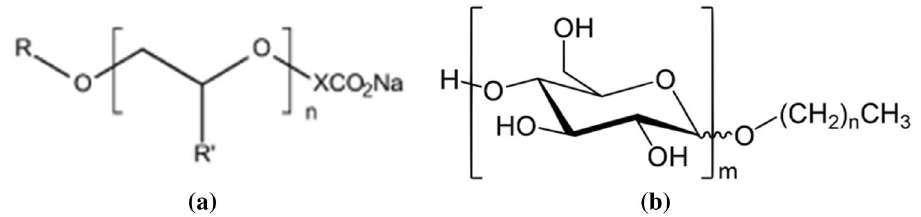
ether carboxylate and alkyl polyglucoside surfactants obtained from the